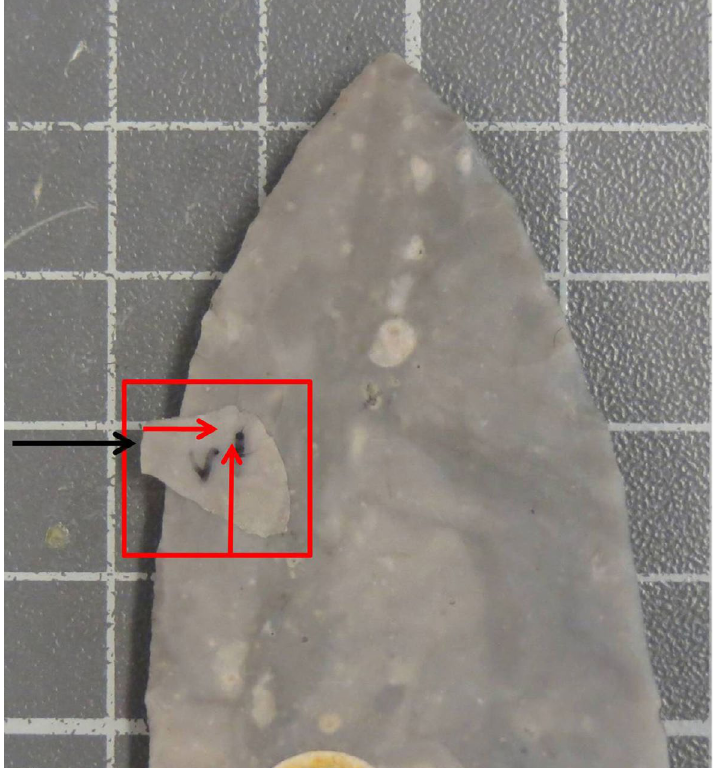
Figure 10. Blade-point 4.2, flake v1 with the black arrow showing direction of removal blow and the red arrows the dorsal scarring (photograph by the author). Gridlines on this image are 10mm